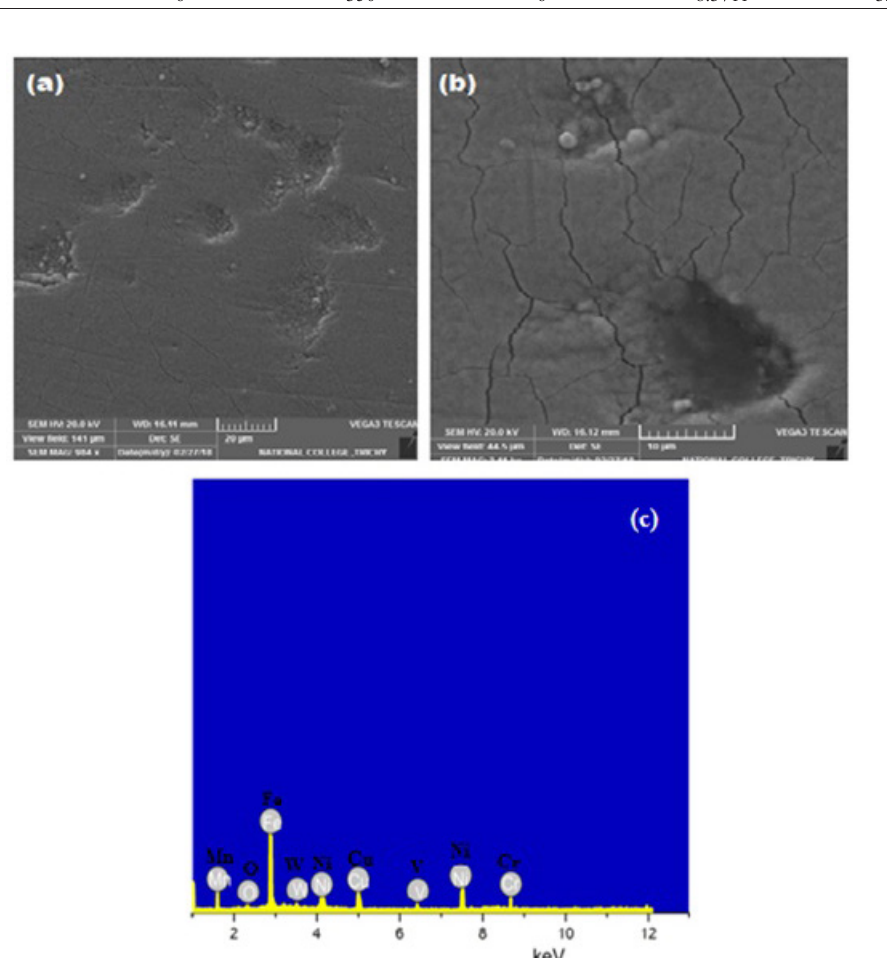
Figure 1. Scanning Electron Microscope (SEM) analysis of alloyed surface by Cu-10Ni-2Cr at (a) peak current of 6A, compaction pressure of 300 MPa and 2 wt.% Cr (b) peak current of 9A, compaction pressure of 250Mpa and 6 wt.% Cr(c) EDS result of modified layer using